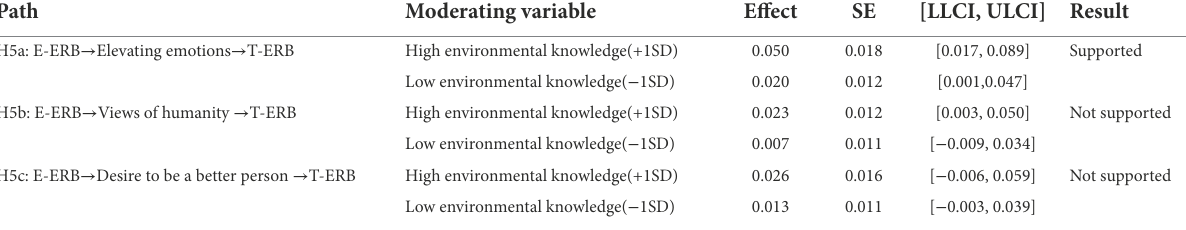
TABLE 6 Results of the moderated mediation